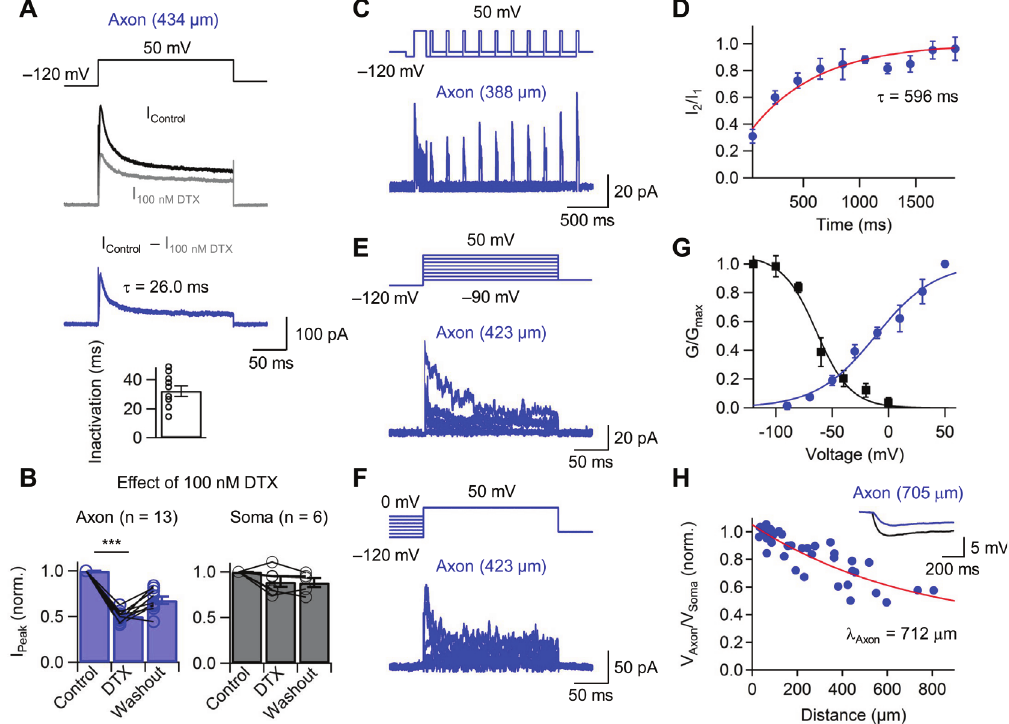
Figure 2. Inactivating axonal Kv1 channels and long length constant of the axonal cable are the key mechanisms underlying axonal AP modulation. (A) Top, K + current evoked in outside-out patches from the axon (434 m m) of CA1 pyramidal neuron by 200-ms pulses to 50 mV in the absence (Black trace, I Control ) and presence (Gray trace, I 100 nM a -DTX ) of 100 nM a -DTX. Middle, the blue trace represents the a -DTX-sensitive current component obtained by digital subtraction. Bottom, bar plot of the average time constant of inactivation (n=10). (B) Summary bar graph showing the effect of 100 nM a -DTX in axonal patches (left, P , 0.001, n=13) and somatic patches (right, P . 0.1, n=6). Bars indicate mean 6 SEM; circles denote individual experiments. Data points for the same experimental conditions are connected by lines. (C) Recovery of a -DTX-sensitive K + channel from inactivation. Stimulation protocol and example traces of recovery from inactivation, as probed with a double-pulse protocol (100-ms prepulse to –120 mV, 150-ms conditioning pulses and 30-ms test pulses to + 50 mV, separated by a recovery interval of variable duration at –120 mV). The holding potential before and after the pulse protocol was –90 mV. Axonal patch is 388 m m from the soma. (D) Summary plot of the amplitude of the peak current evoked by the test pulse, divided by that evoked by the conditioning pulse, plotted against interpulse interval. Data points represent means from 5 patches. Red curves represent double-exponential fit to the data points. (E, F) Gating properties of a -DTX-sensitive axonal K + channels. Stimulation protocol and traces of activation and steady-state inactivation of a -DTX-sensitive K + channels in CA1 pyramidal neuron axons. (E) To probe steady-state activation, a 100-ms prepulse to –120 mV was followed by a 200-ms test pulse to various potentials (–120 to 50 mV). (F) To test steady-state inactivation, a 5-s prepulse to various potentials (–120 to 0 mV) was followed by a 200-ms test pulse to 50 mV. Axonal patch is 423 m m from the soma. (G) Activation (blue circles) and steady-state inactivation (black squares) curves. Conductance values were normalized to the maximal value. Data points represent means from 8 patches for activation curve and 6 patches for steady-state inactivation. Blue curves represent Boltzmann functions fit to the data points. For the activation curve (blue line), the midpoint potential was –12 mV and the sloe factor 26.4 mV. For the inactivation curve (black line), the midpoint potential was –64 mV and the slope factor 15.2 mV. (H) Length constant of the CA1 pyramidal neuron axons. Plot of axonal to somatic voltage deflection during hyperpolarizing current pulses (1 s, –30 pA) applied at the soma, plotted against distance. Each data point represents a simultaneous axon–soma recording. Red line represents a fit of data points with an exponential function, resulting in a mean length constant of 712 m m. Note that the long length constant results in particularly efficient propagation of subthreshold membrane potential changes from the soma to the axon. (Inset) voltage changes recorded in the soma (black) and the axon (blue) during hyperpolarizing current pulses applied at the soma. Axonal recording site is 705 m m from the soma. Traces shown represent average of 20 (A, black trace), 22 (A, gray trace), 2 (C), 3 (E), and 2 (F) single sweeps. Transient inward Na + currents at the beginning of the pulse are truncated. Error bars,